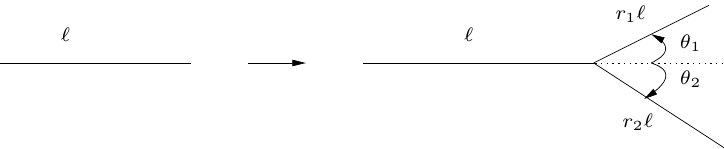
Figure 2. A simple branching generator with two branches ( N = 2), branching angles θ 1 and θ 2 , and contraction factors r 1 and r 2